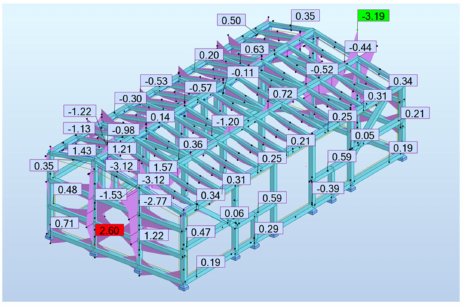
Figure 13. Static strength analyses, bending moment